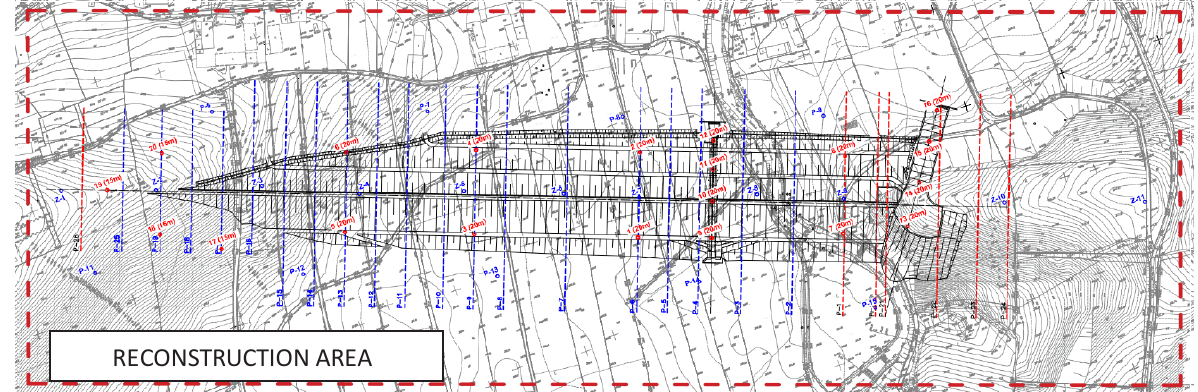
RECONSTRUCTION AREA